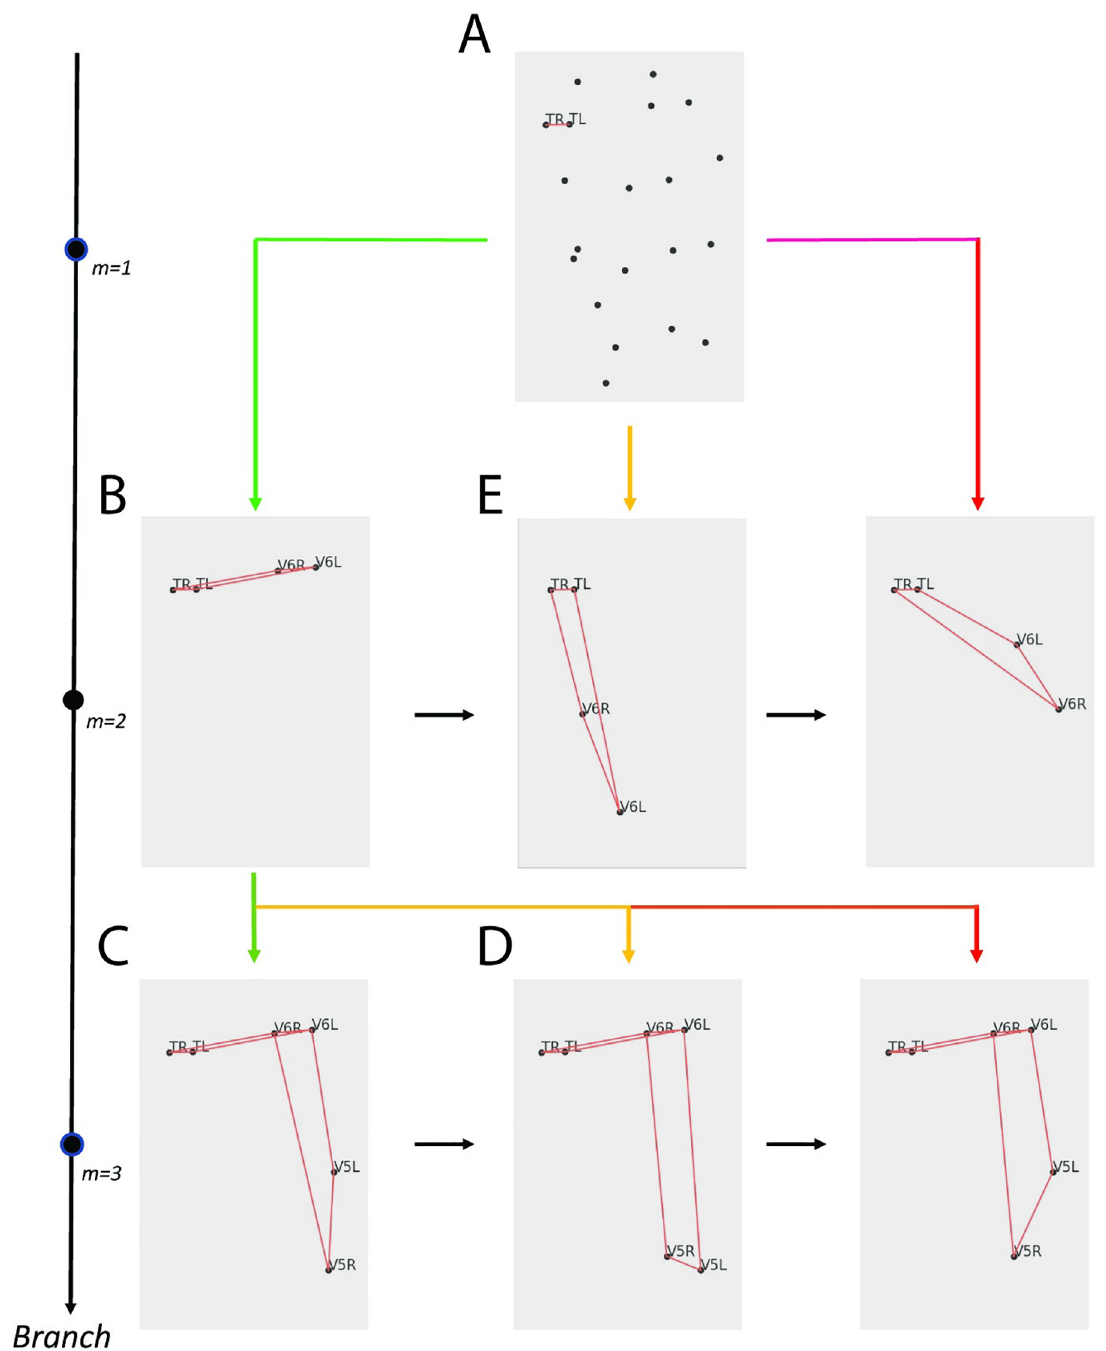
Fig 9. EHGM applied to the sample image depicted in Fig 1A. A: Two points are selected at the initial branch for TL and TR , respectively. Candidates for the successive pair, V6L and V6R , are queued based on hypergraphical relationships between the established cell identities TL and TR and each hypothesized V6 pair (lower costs are green to higher costs in red). B: The leading hypothesis at branch m =2 given the initial branch pair is chosen. The recursion continues to queue V5 pair choices at branch m =3. Black arrows within branch m specify the ordering of the branch given established cell assignments. Each branch creates a new subproblem of completing the posture given partially assigned identities. C: The tree continuing from the V5 pair hypothesis is fully explored according to the established recursion. D: The next leading V5 hypothesis is initiated upon exhaustion of the subtree formed at panel C. E: Implicit enumeration of the subtree formed at panel B causes the search to progress to the second leading V6 hypothesis.